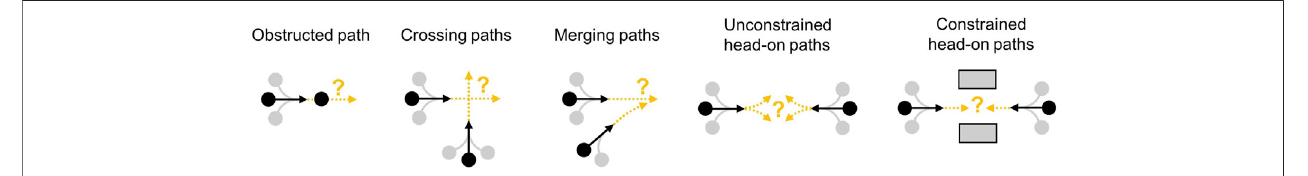
FIGURE 1 | Prototypical space-sharing scenarios based on Markkula et al.